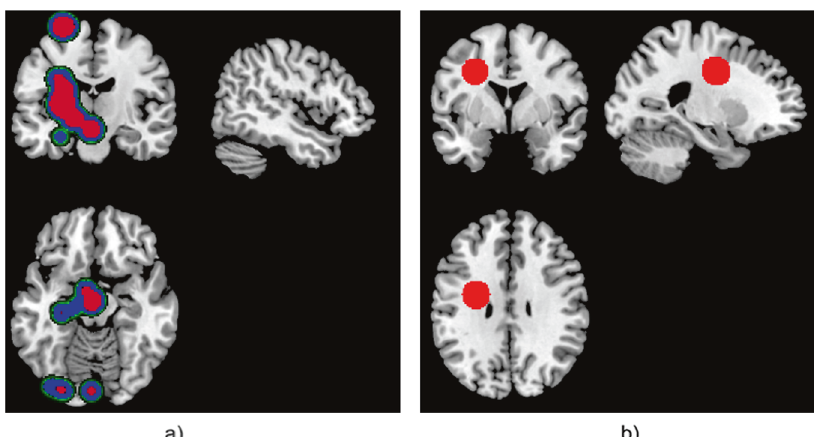
Fig. 4 Visualization of the relevance of the voxels in each class for the classi fi cation schema (b). We demonstrated the smoothed PR with a 7 × 7 × 7 Gaussian kernel of the correct classi fi ed subjects of each group against the other in classi fi cation schema (b), FEP vs. CHR_NT for the registered texture feature map: a difference of entropy and b contrast. The red (cluster 1), blue (cluster 2), and green (cluster 3) color corresponds to the sorted clusters according to the number of subjects belong to each cluster.